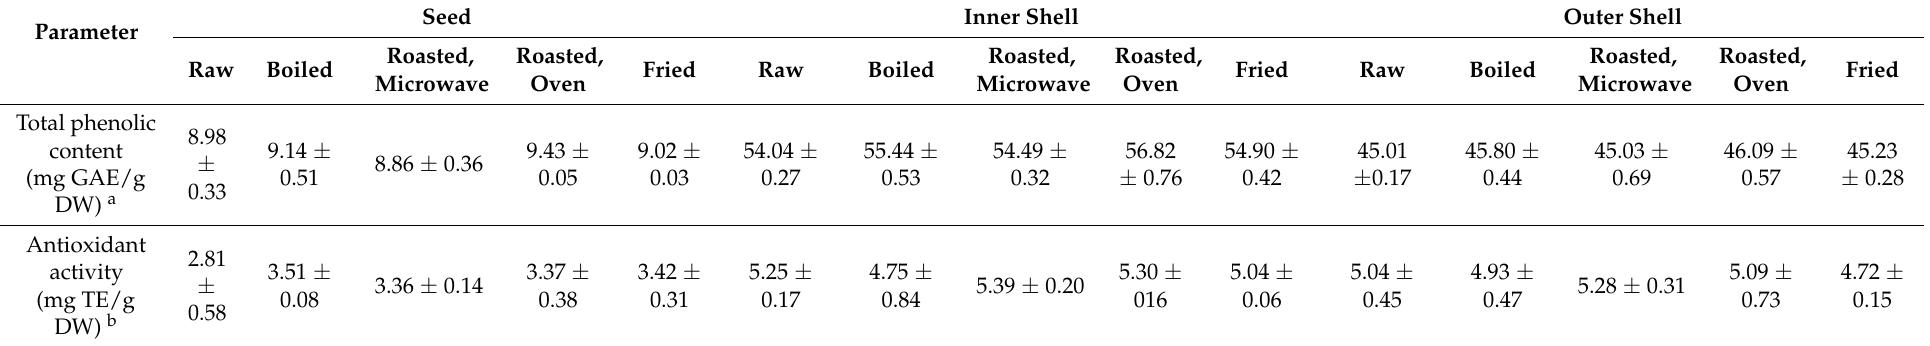
Table 3. Contents of total phenolics determined by Folin–Ciocalteu assay, and the antioxidant activity (DPPH) of chestnut seeds and shells. Seed Inner Shell Outer Shell Parameter Roasted, Roasted, Raw Boiled Fried Raw Boiled Oven